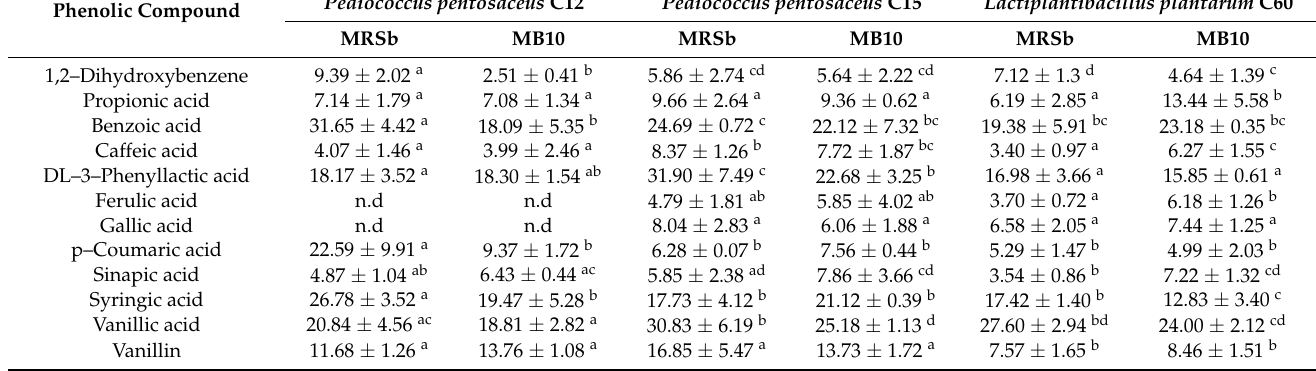
Table 5. The concentration of phenolic compounds in Man, Rogosa and Sharpe broth (MRSb) and meat broth (MB10) fermented by antifungal LAB. The broths were fermented for 48 h at 37 ◦